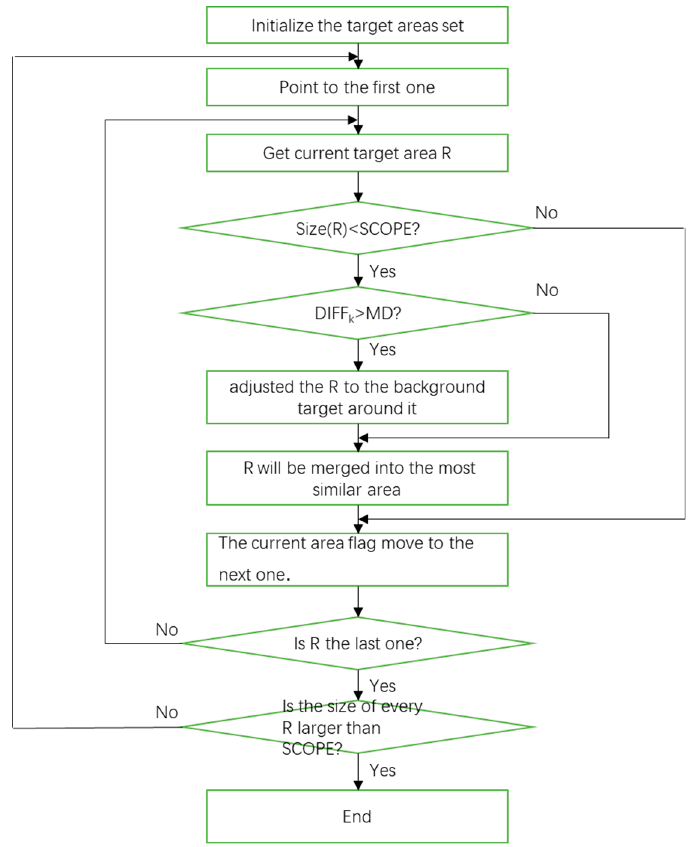
Figure 1. Flow chart for local edge preservation algorithm (LEPA).